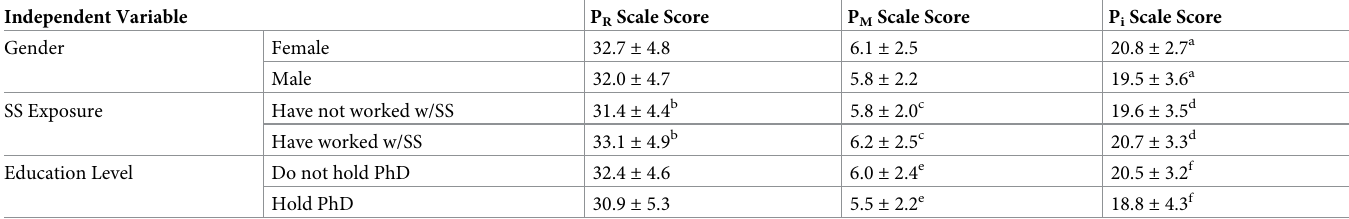
Table 5. Social science scores across gender, social science exposure, and education level. Higher values indicate more favorable perceptions of respect (P R ), methodo- logical rigor (P M ), or intelligence (P i ). Standard deviation is given with the average scale scores. Items with superscripts of the same letter are significantly different from one another (p < 0.05). Independent